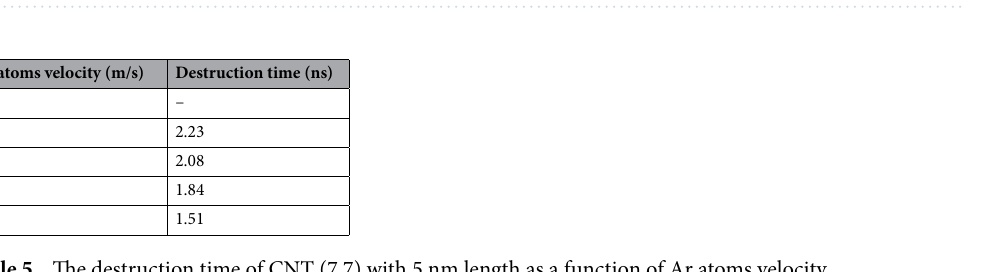
Figure 11. The destruction time of CNT (7,7) with 5 nm length in the vicinity of Ar atoms as a function of fluid velocity.